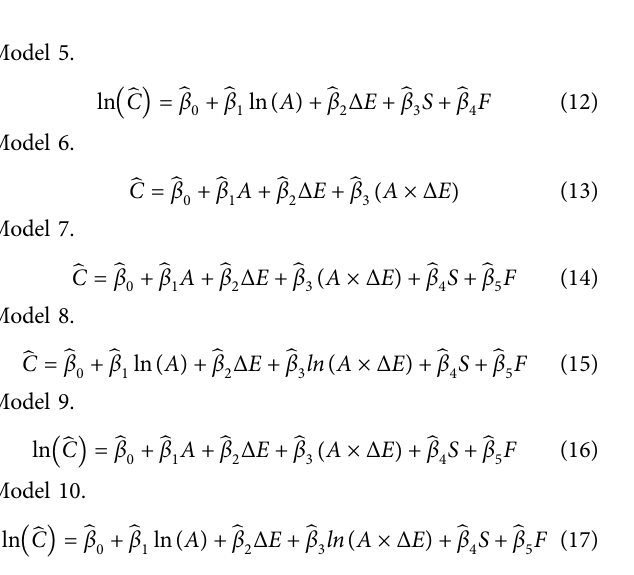
Frontiers in Built Environment |